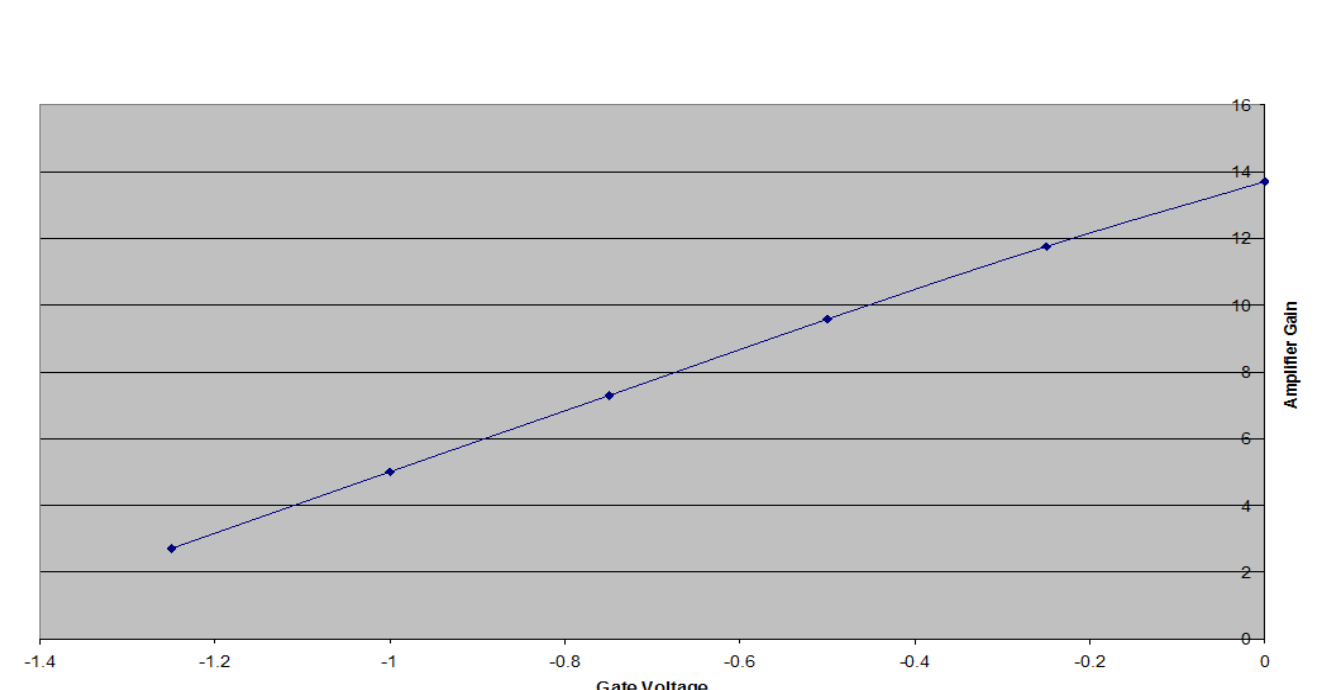
Fig. 4: The voltage gained controlled